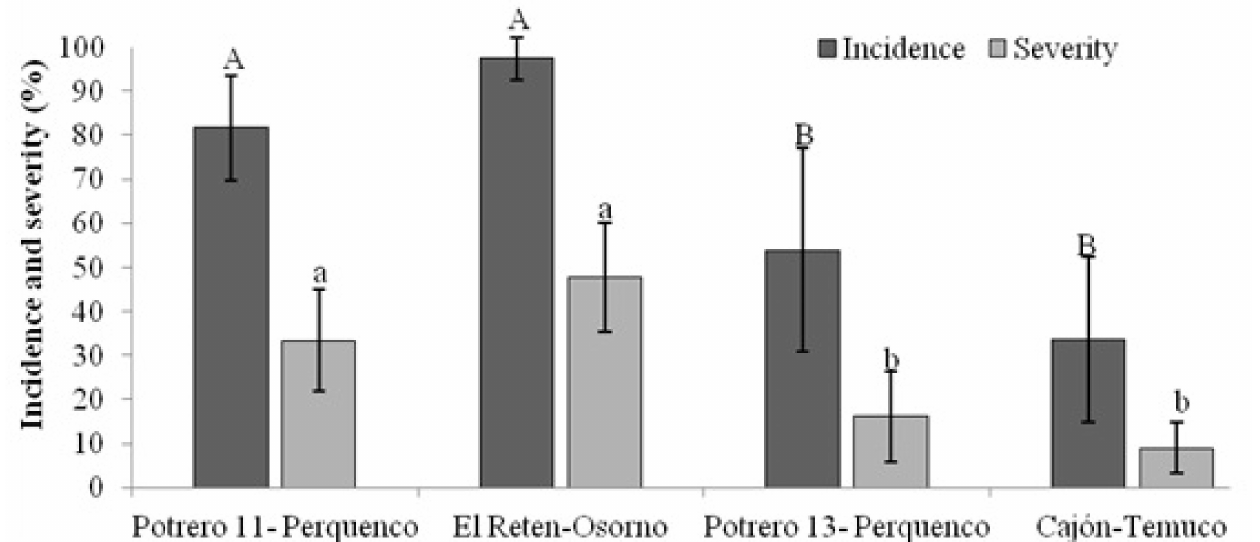
Figure 2. Incidence and severity of microorganisms causing culm-darkness of the first internode in wheat plants obtained from four intensively sampled fields in southern Chile during the grain-filling period. Letter differences on columns of the same color were significantly different, according to the Kruskal–Wallis test ( p <